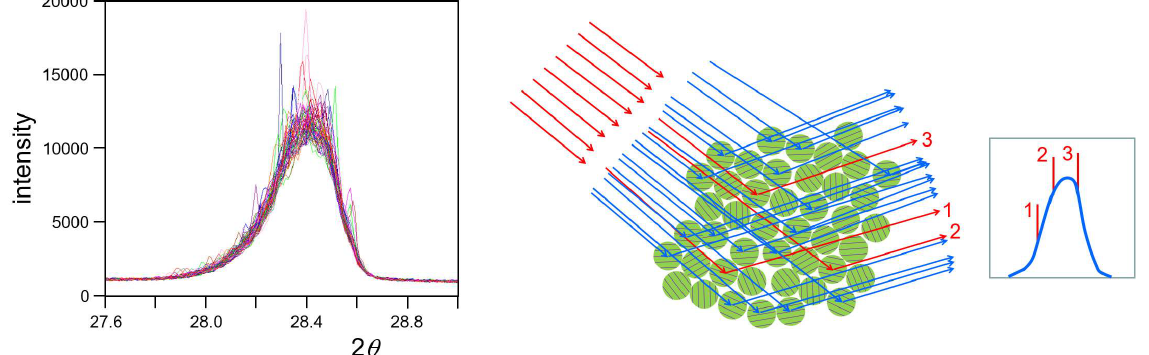
Figure 7. ( a ) A series of twenty superimposed profiles from a Si polycrystalline sample through a powder diffraction ring with a fixed incident angle (with a divergence of 0.0625 0 and 2.3 0 Soller slits) and a stationary position sensitive detector. The sample was rotated about an axis normal to the surface between each experiment. For each profile, there are two distinct regions, a few sharp peaks and a smooth broad profile. ( b ) A schematic of the origins of a profile. The divergent incident beam captures 3 crystals in the Bragg condition to form sharp peaks with widths corresponding to their size and a broad profile of non-Bragg contributions with a shape defined by the diffractometer